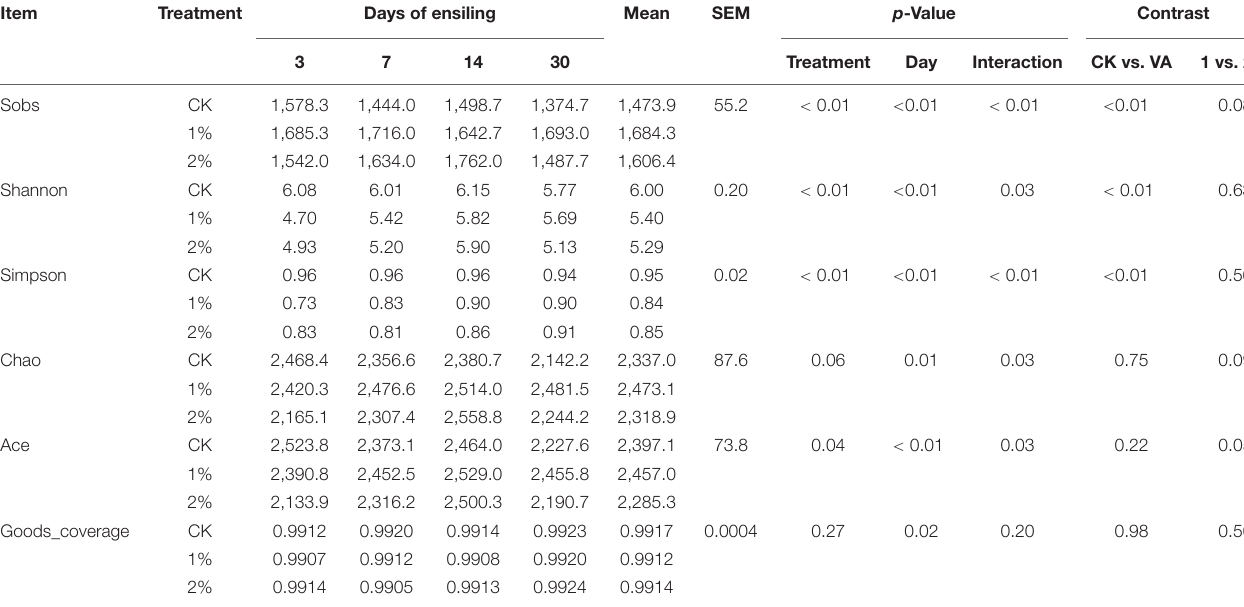
TABLE 3 | Effect of vanillic acid on bacterial alpha diversity of stylo silage. Item Treatment